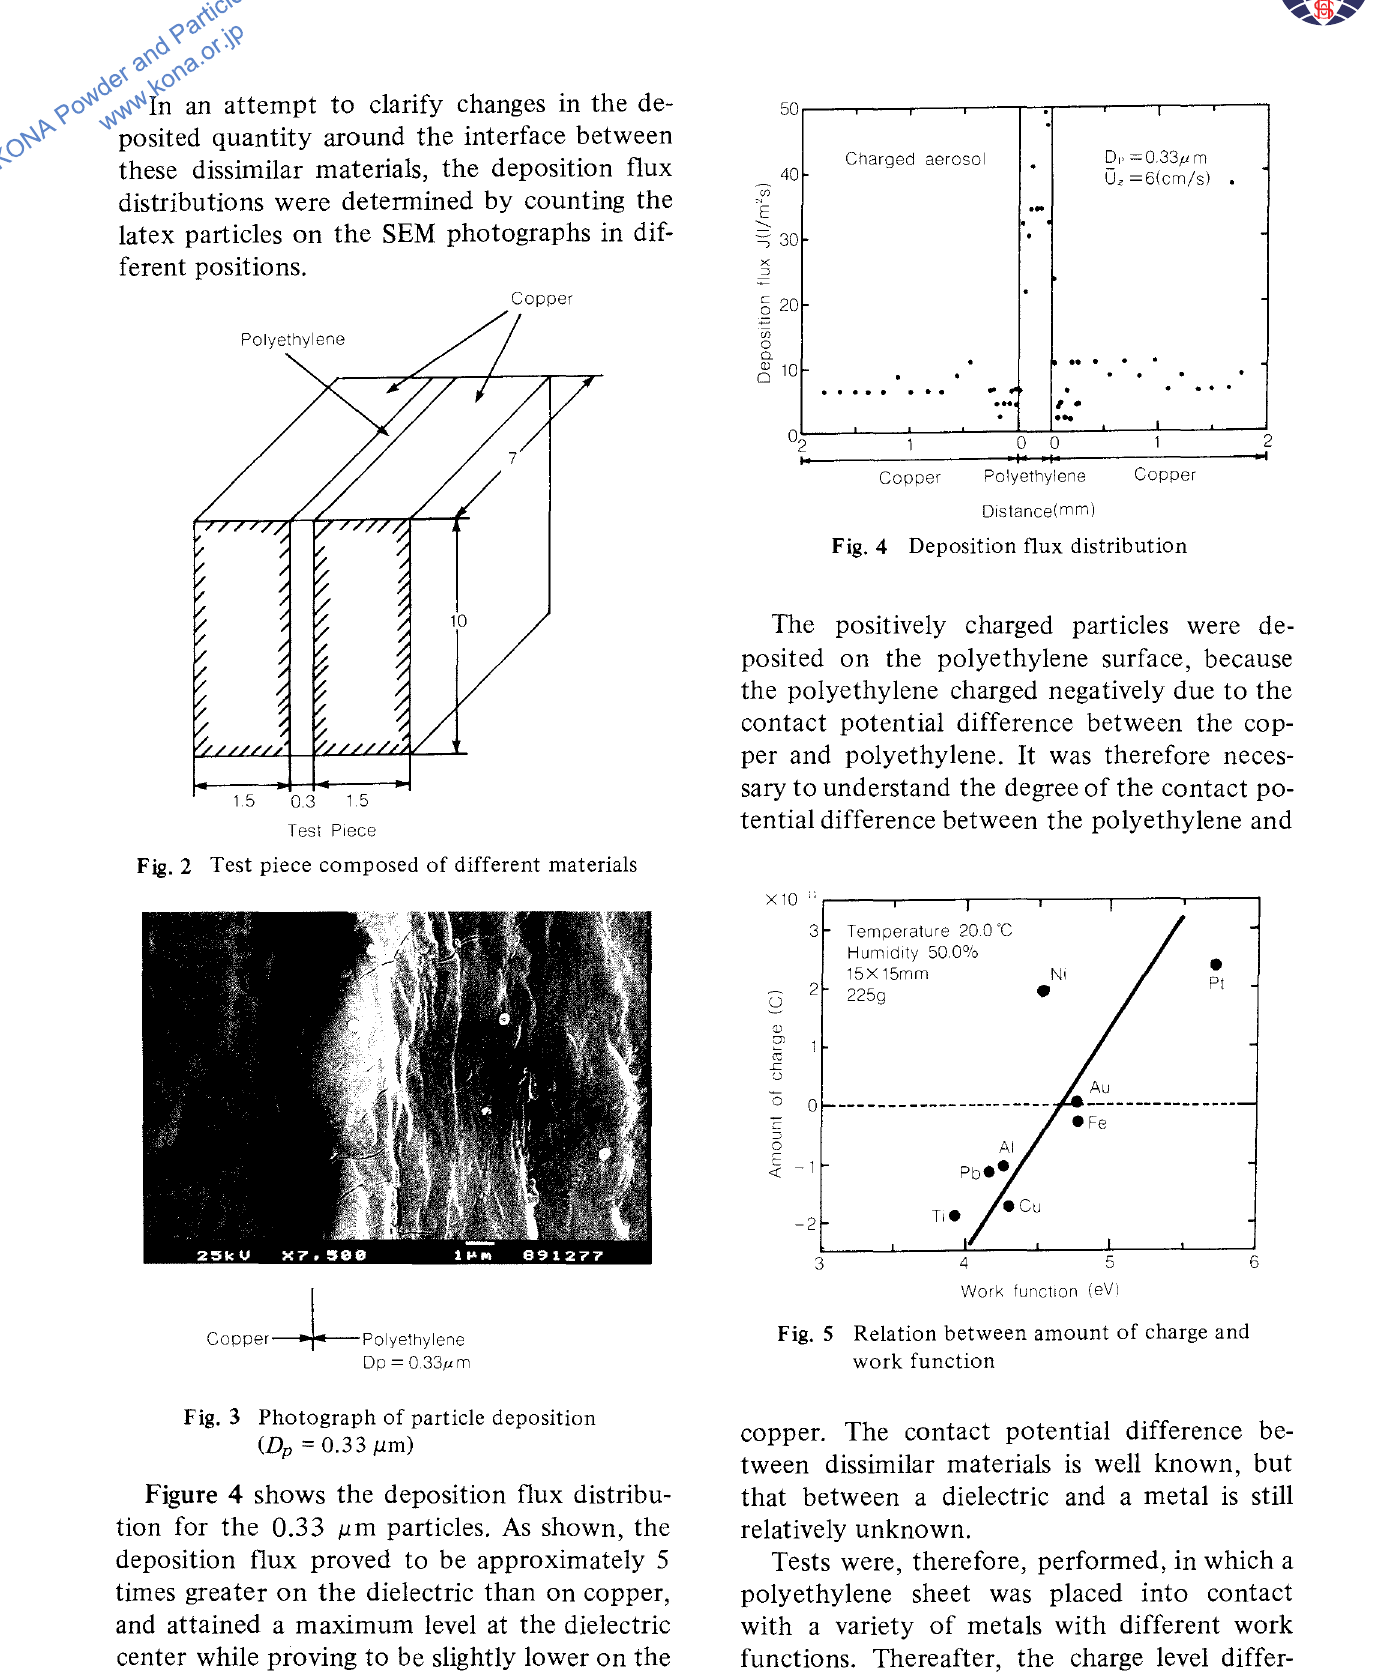
Dp=033pm Fig. 3 Photograph of particle deposition Wp = 0.33 Jlm)